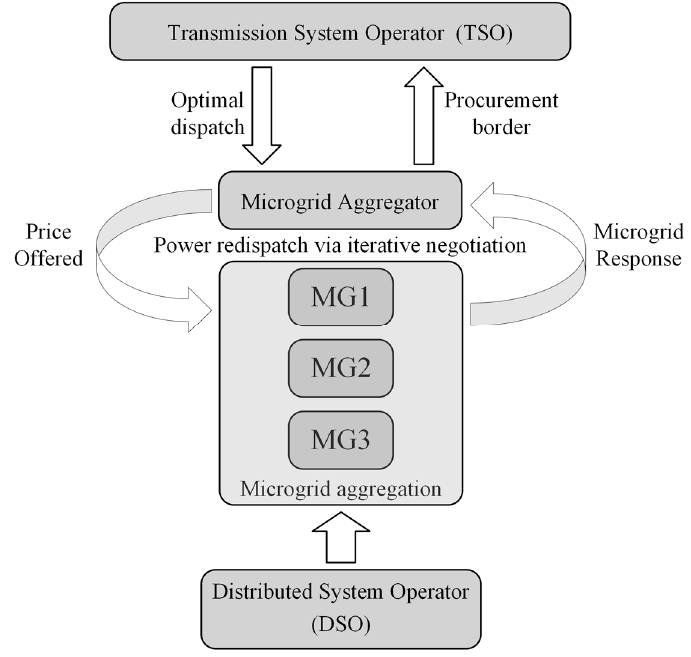
Figure 5. Example setup of microgrid market players.